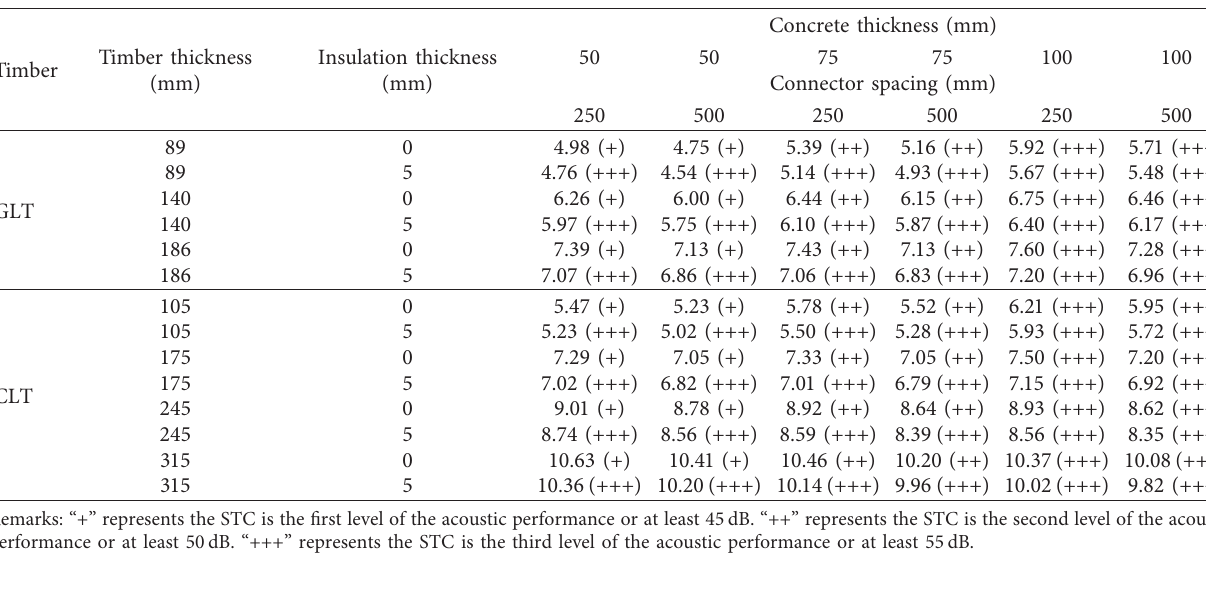
Table 4: Influence of connection properties on TCC floor allowable spans.